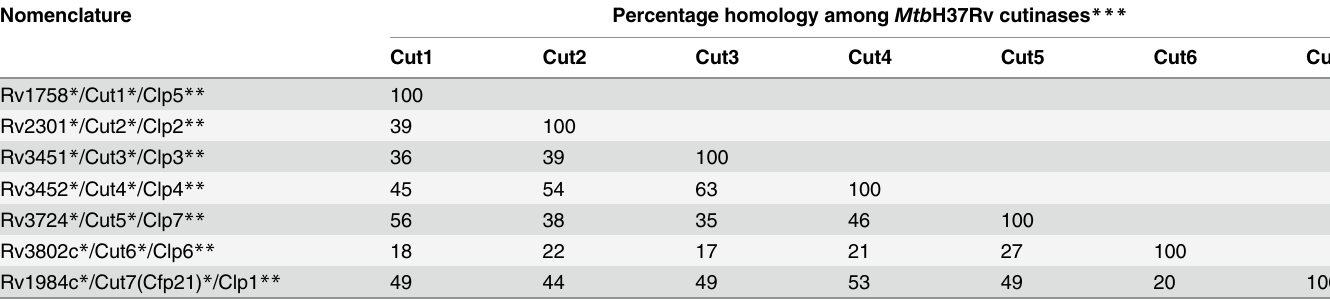
Table 1. Percentage homology based on amino acid sequences of cutinases of Mtb H37Rv.